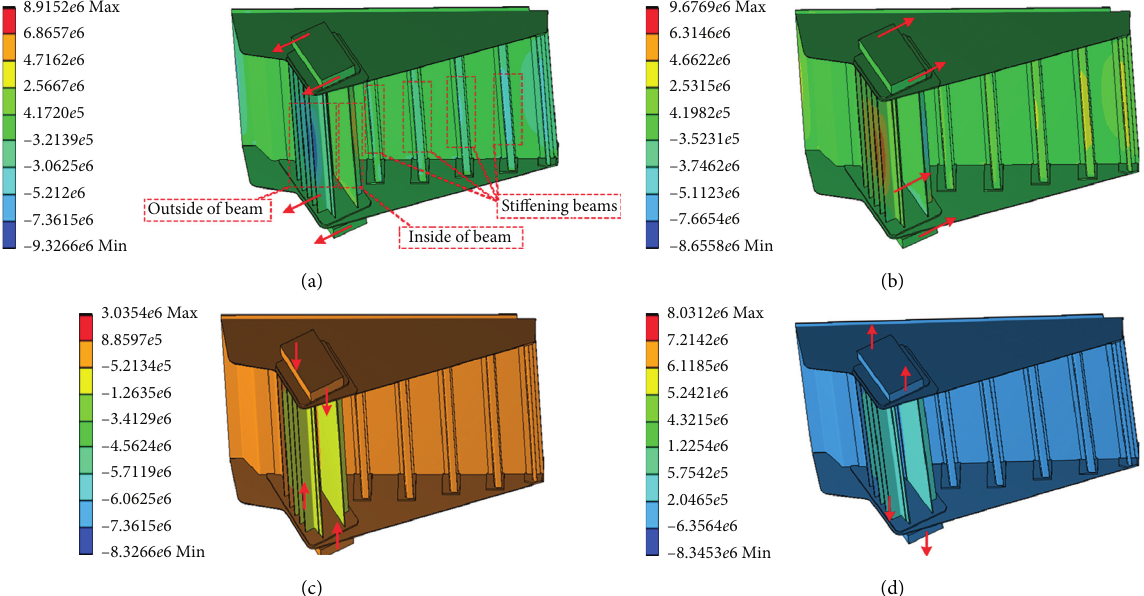
Figure 9: First principal stress cloud of vibrating feeder at four special moments in one cycle: (a) same direction and backward; (b) same direction and forward; (c) reverse and inward; (d) reverse and